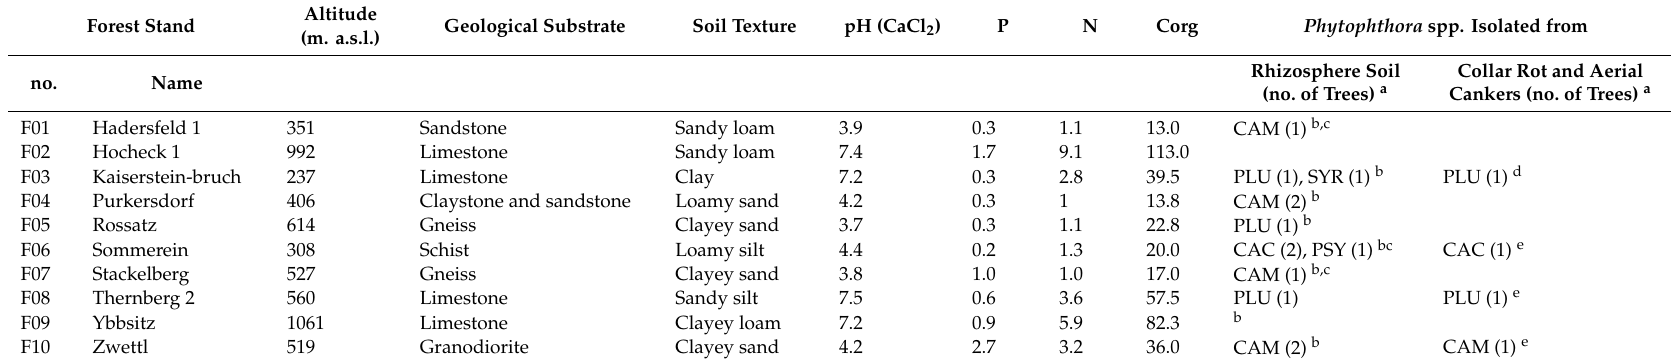
Table 1. Altitude, geological substrate, soil texture, mean pH and concentrations (g × Kg − 1 ) of phosphorous, nitrogen and organic carbon in 10 intensively surveyed beech stands in Lower Austria, and Phytophthora species isolated from rhizosphere soil and bleeding bark cankers of declining and non-declining mature beech trees (n = 6–9 per stand). Altitude Forest Stand Geological Substrate Soil Texture pH (CaCl 2 ) P N Corg Phytophthora spp. Isolated (m. a.s.l.)